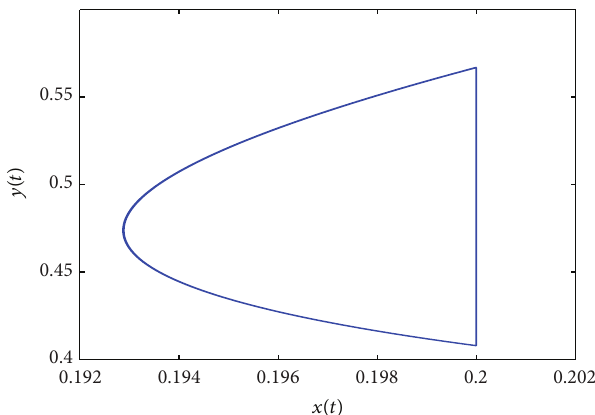
Figure 8: Plots of the positive periodic solution when (1 − 𝛼)ℎ 2 < < ℎ < 𝑥 ∗ with ℎ ℎ 1 2 = 0.16 . 𝜏 1